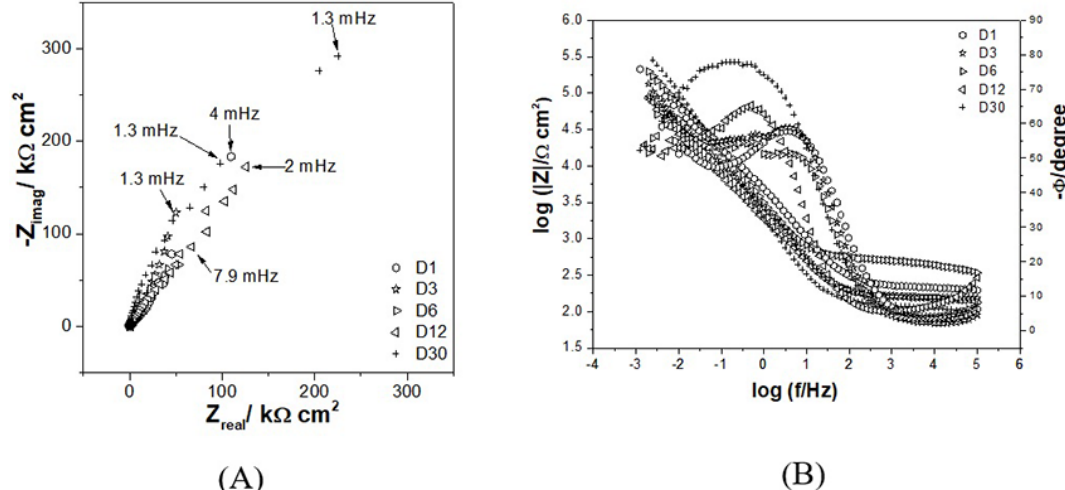
Figure 4. Experimental complex plane and Bode plots for 80-20 sample in non-aerated and unstirred Hanks' solution without BSA for 30 days of immersion at 37 ºC: (A) complex plane plots; (B) Bode - phase angle vs . log f and impedance modulus vs . log f plots.